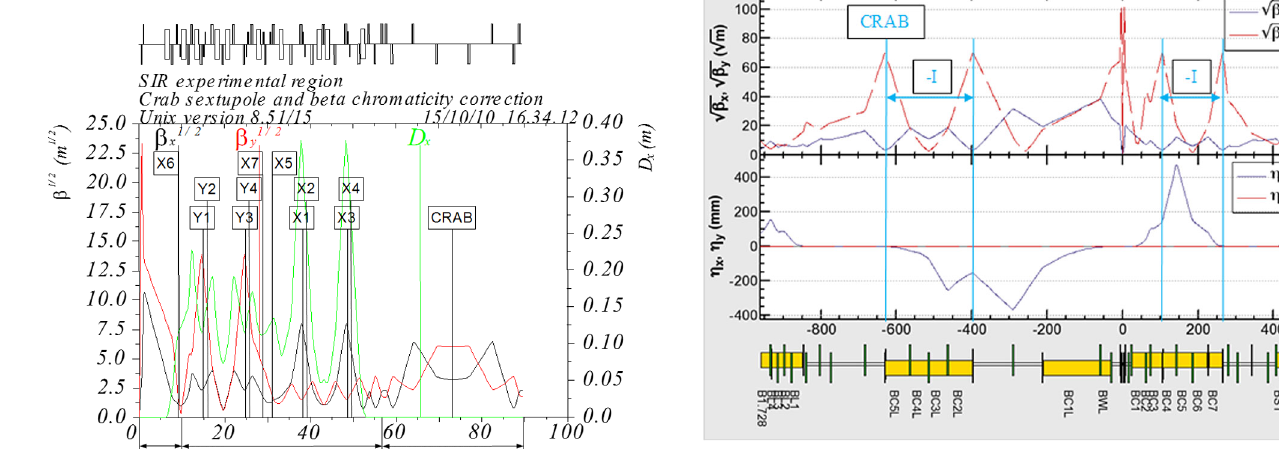
FIG. 9. Optical functions of the CTau interaction